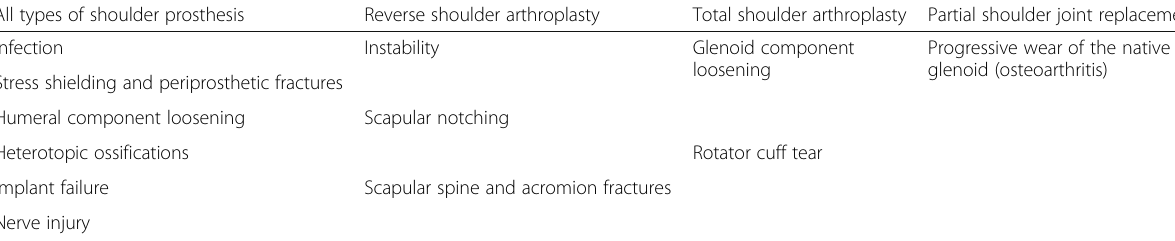
Table 1 Summary table of the different complications of shoulder arthroplasties All types of shoulder